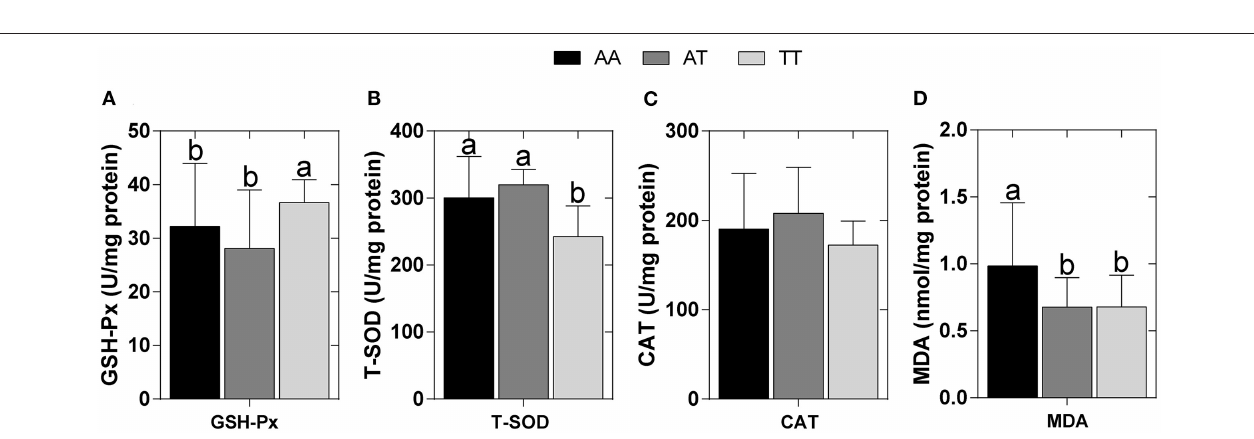
FIGURE 4 | Hepatic antioxidant indices in different genotyped layers. (A) Glutathione peroxidase (GSH-Px) activity; (B) Total superoxide dismutase (T-SOD) activity; (C) Catalase (CAT) activity; (D) Hepatic malondialdehyde (MDA) levels. AA, AA genotype hens; AT, AT genotype hens; TT, TT genotype hens. Values are expressed as means ± SD, n = 9 hens each genotype. a , b Means within a histogram with no common superscripts differ significantly ( P < 0.05).